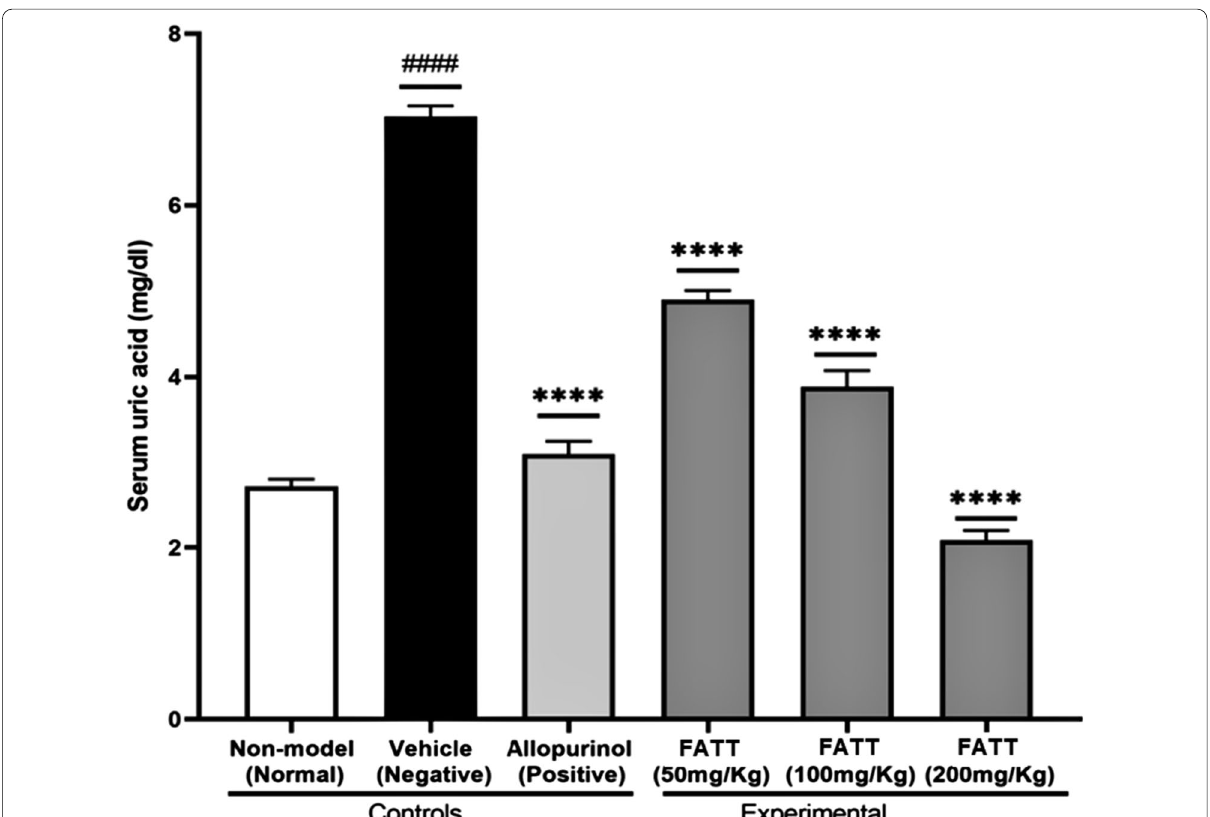
Fig. 3 One-way ANOVA (with Tukey’s post hoc) comparison of serum uric acid (SUA) levels of experimental (FATT-treated) and control mice groups. Data are presented as mean SEM ( n 8); SUA levels of negative and normal controls were compared to ensure SUA elevation before treatment; ± = SUA levels of each of FATT-treated and negative control groups were compared to evaluate FATT’s SUA-lowering effects. There was a highly significant SUA elevation before treatment ( #### p < 0.0001); similarly, there was a highly significant SUA lowering in each of the 50, 100 and 200 mg/ Kg FATT-treated groups (**** p <